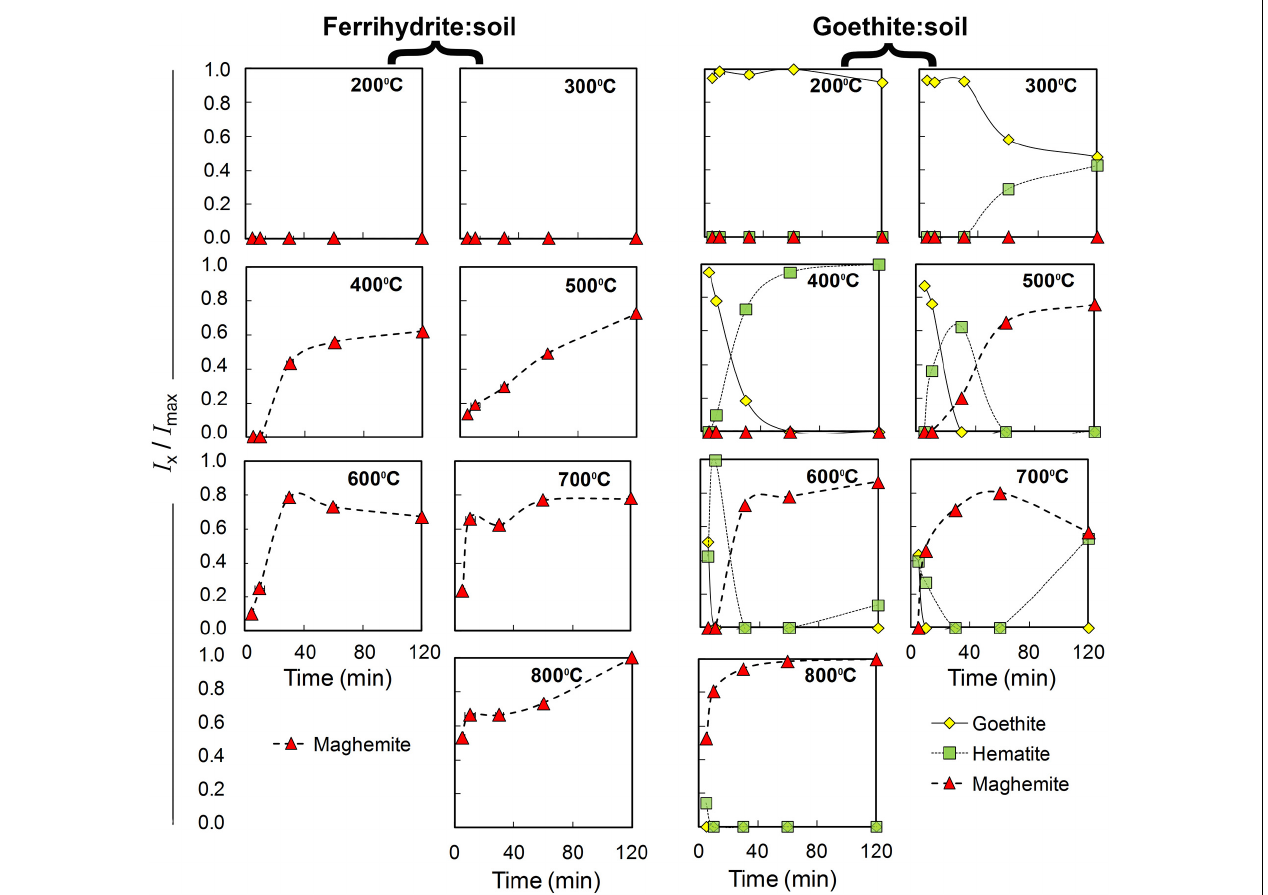
FIGURE 2 | Qualitative estimates of changes in relative abundance of goethite, maghemite and hematite in ferrihydrite:soil and goethite:soil treatments in relation to combustion temperature and combustion duration. Based on normalized X-ray diffraction peak integral intensity (Goethite-111; Maghemite-220; and Hematite-113) derived from Figures 3 , 4 .